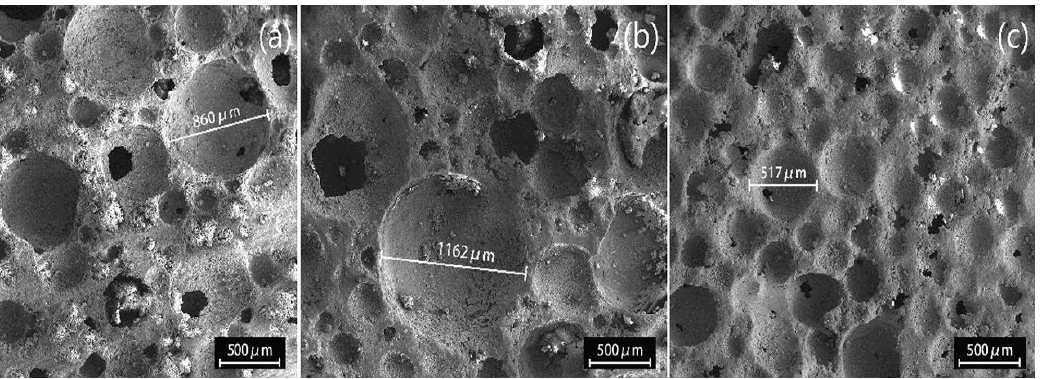
Figure 9 . SEM images of foamed concrete at 100×: ( a ) AS, ( b ) PS, ( c ) SS. Reprinted/adapted with permission from Ref. [36]. 2018, Elsevier Science &Technology Journals.